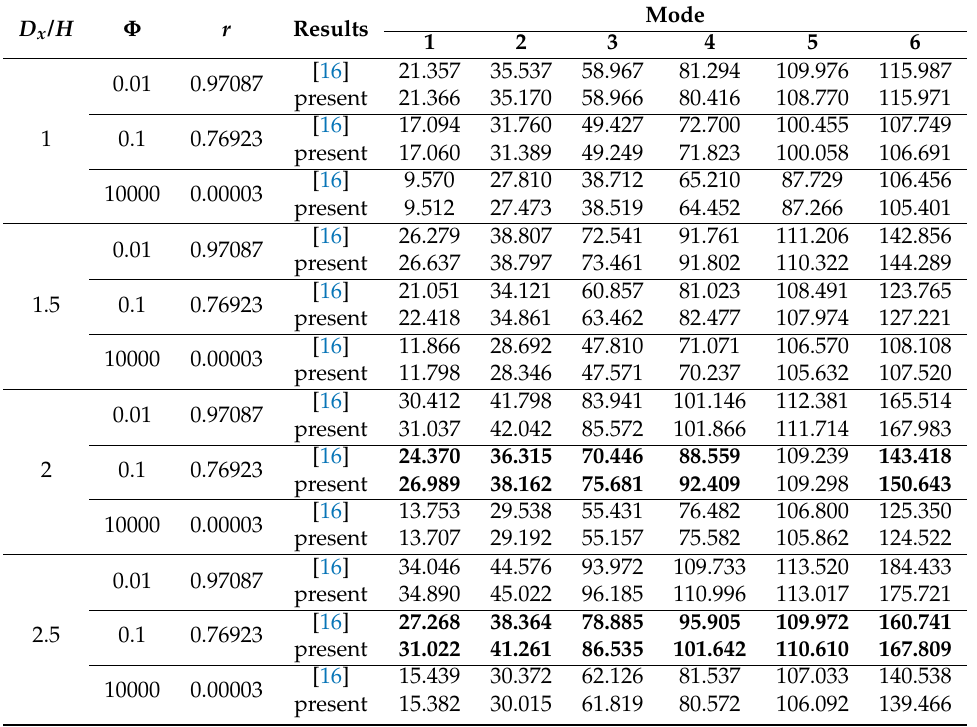
Table 4. First six frequency parameters Ω = ω a 2 stiffness and different rotational fixity factors ( D y / H = 1, ν = 0.3, and a / b =